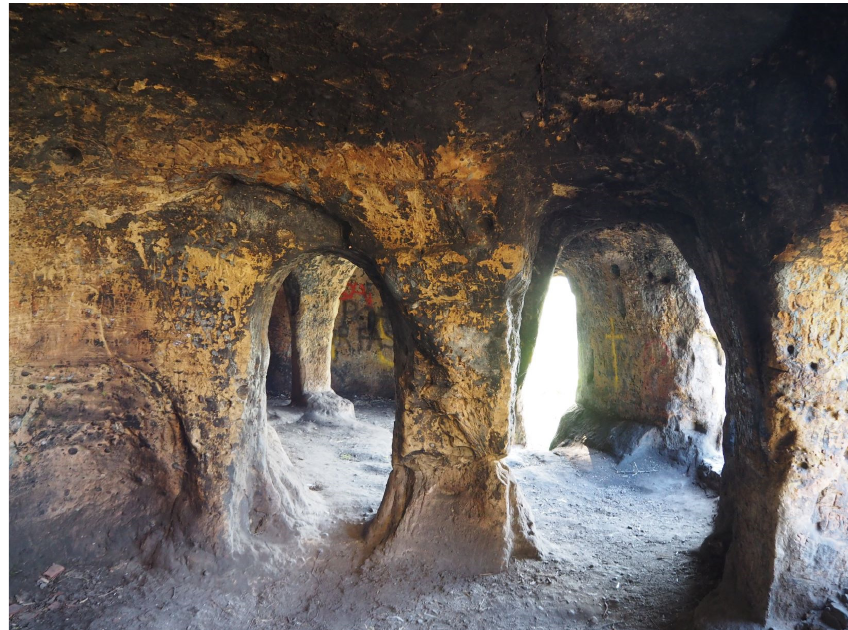
Figure 3: The interior of Anchor Church (Derbyshire): Although thin internal rock walls have been partly removed, features such as tall narrow Romanesque doors and a debased pilaster relate to the initial construction of the structure. Photograph E.R Simons.